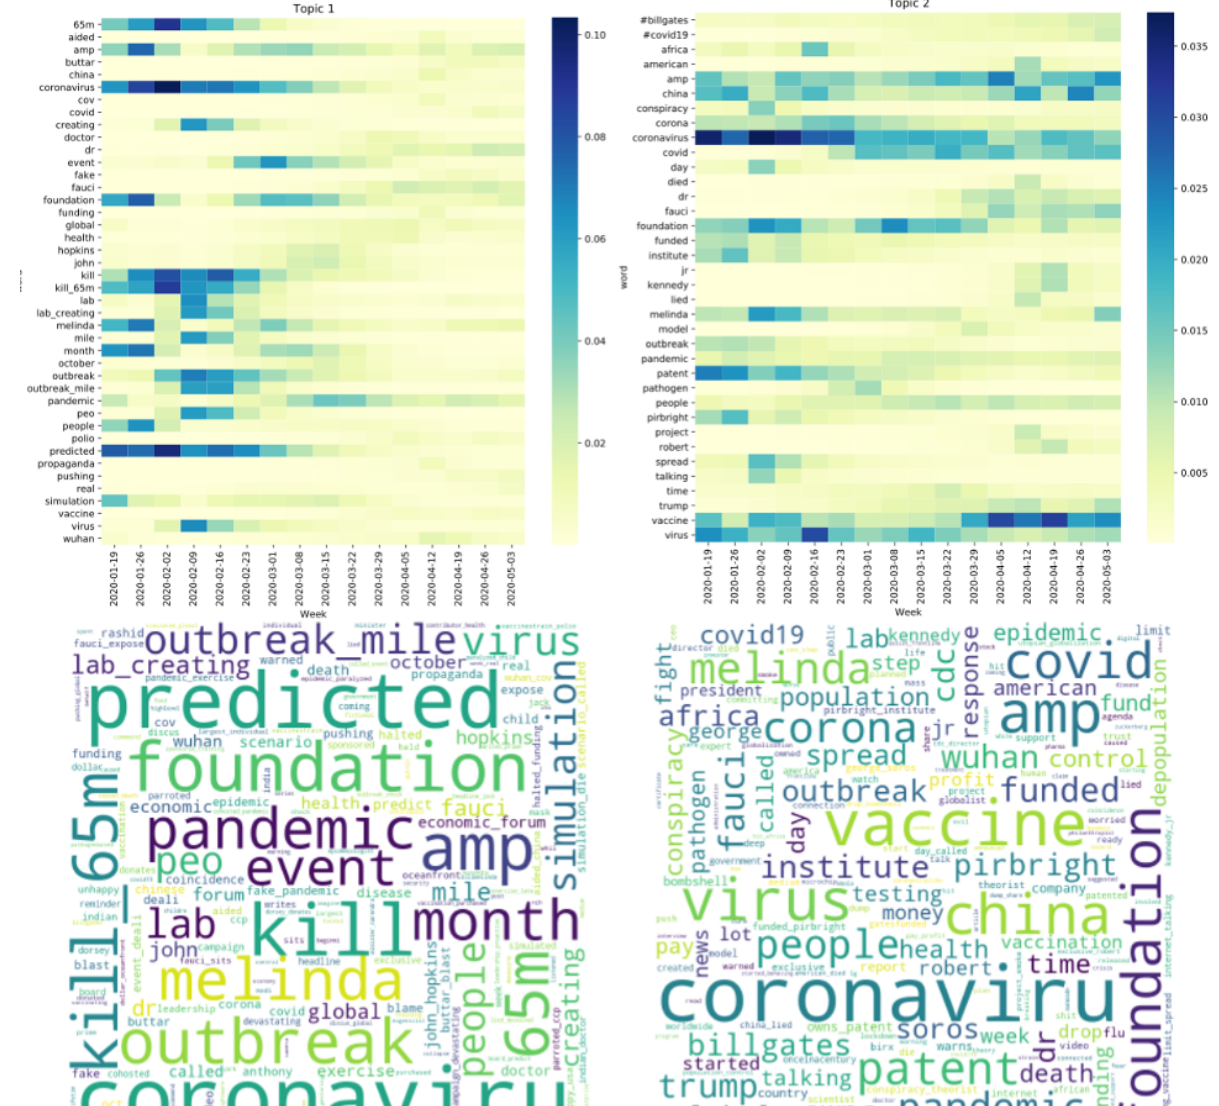
Figure 7. Topic evolutions and word clouds for COVID-19 conspiracy theories related to Bill Gates and the Bill & Melinda Gates Foundation. Top panel: word evolution in the 2-topic dynamic topic model. Color represents the importance of the words, with a darker color denoting higher importance. Bottom panel: word clouds for each topic. The size of each word corresponds to its weight (higher-weighted words are larger in